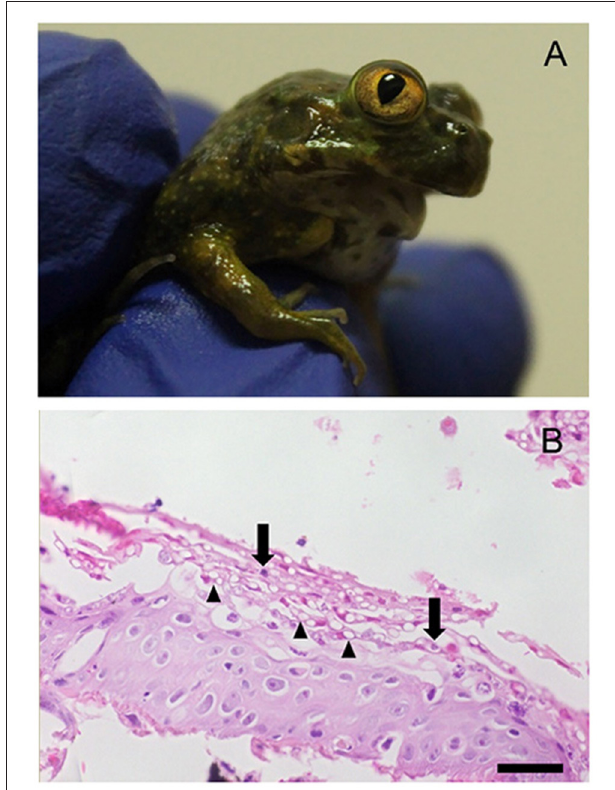
FIGURE 1 | A Chilean giant frog ( Calyptocephalella gayi ) postmetamorph showing signs of disease. (A) Absence of jaw (agnathia). (B) Histological section of hind limb skin. Note distinct stages of developing zoosporangia (arrows) and multiple empty spaces (arrowheads) within the superficial keratinized layer, morphologically typical of Batrachochytrium dendrobatidis infection. Stained with hematoxylin and eosin. Bar = 24 µ m (bottom).